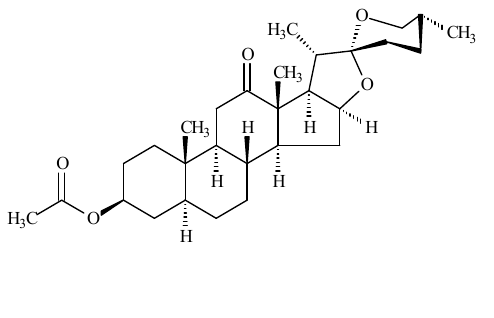
Figure 1. Chemical structure of hecogenin